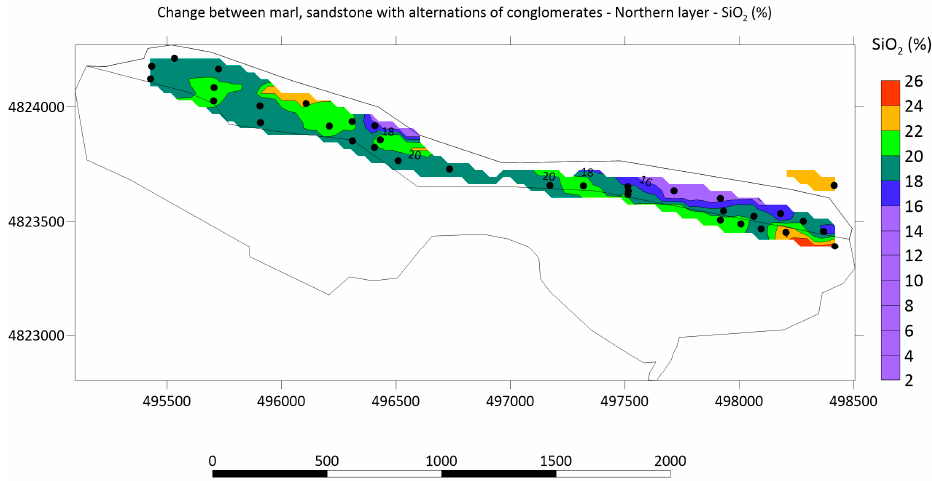
Figure 9. Map of SiO 2 (%) in unit (1), northern layer (boreholes are black Figure 9 . Map of SiO 2 (%) in unit (1), northern layer (boreholes are black dots). Figure 9 . Map of SiO 2 (%) in unit (1), northern layer (boreholes are black dots). Figure 9 . Map of SiO 2 (%) in unit (1), northern layer (boreholes are black dots).